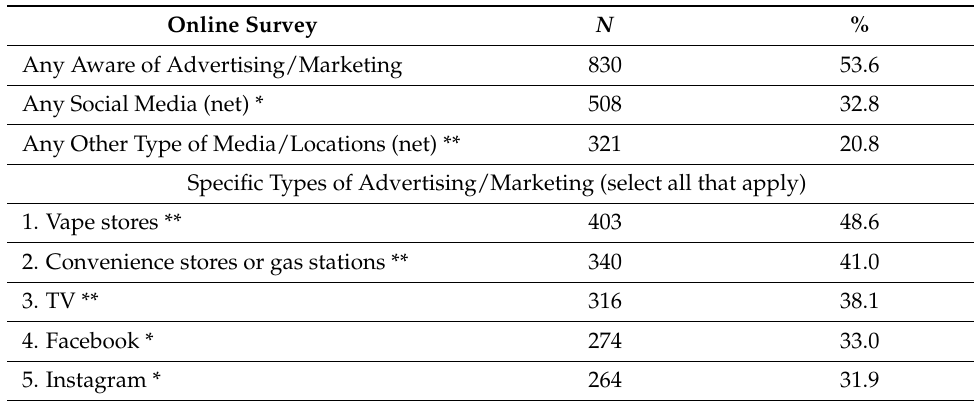
Table 2. Awareness of ENDS advertising or marketing—Quantitative